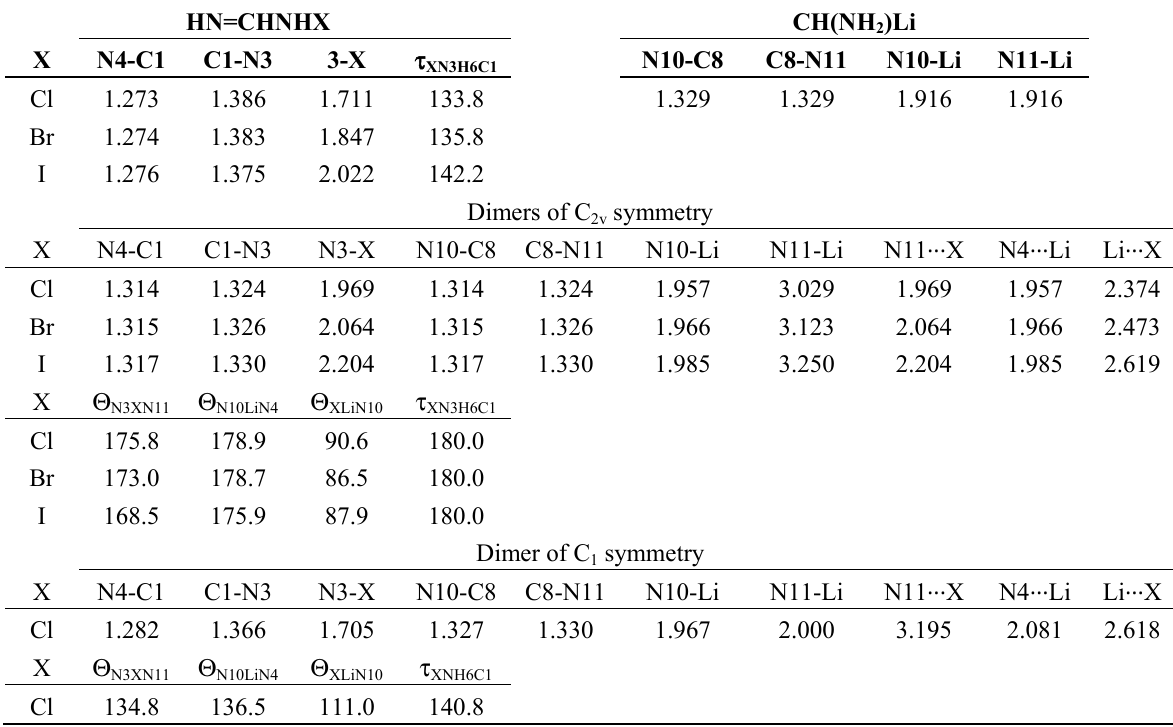
Table 2. Selected geometrical parameters for HN=CHNHX and CH(NH the MP2/aug-cc-pVTZ level. Distances in Å, and angles in degrees.